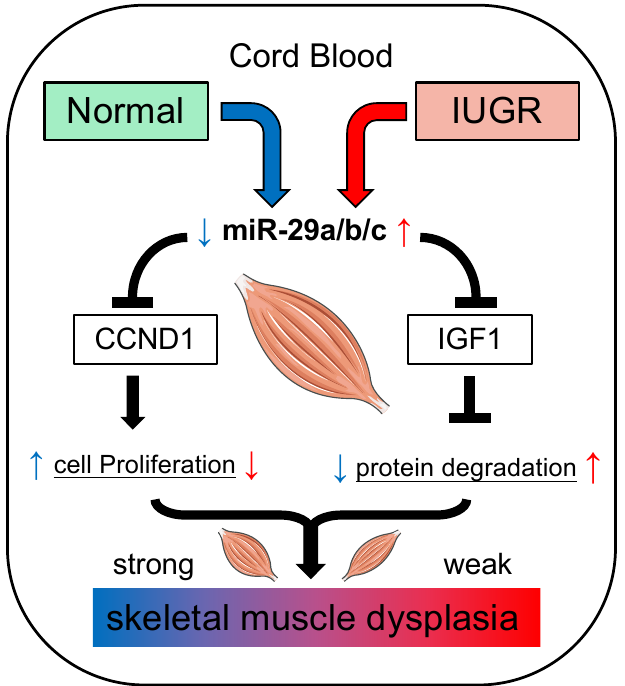
Figure 8. The miR-29 family is involved in the regulation of skeletal muscle development in IUGR pigs. This section may be divided into subheadings; it should provide a concise and precise description of the experimental results, their interpretation, as well as the experimental conclusions that can be drawn.